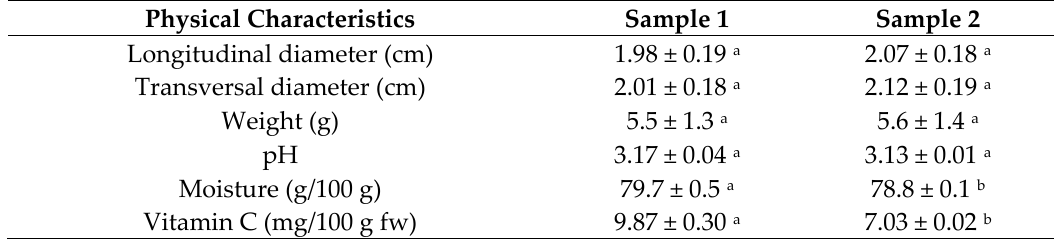
Table 1. Physicochemical characteristics of Plinia peruviana “Yvapur ũ ”